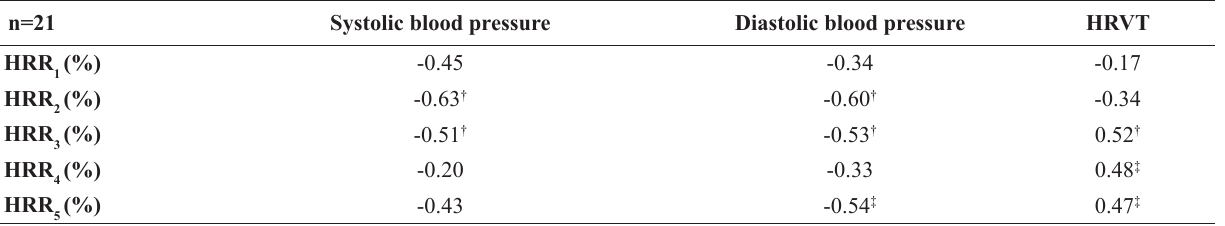
Table 4. Correlation coefficients (r) between heart rate recovery (HRR), resting blood pressure (mmHg) and heart rate variability threshold - HRVT (W).